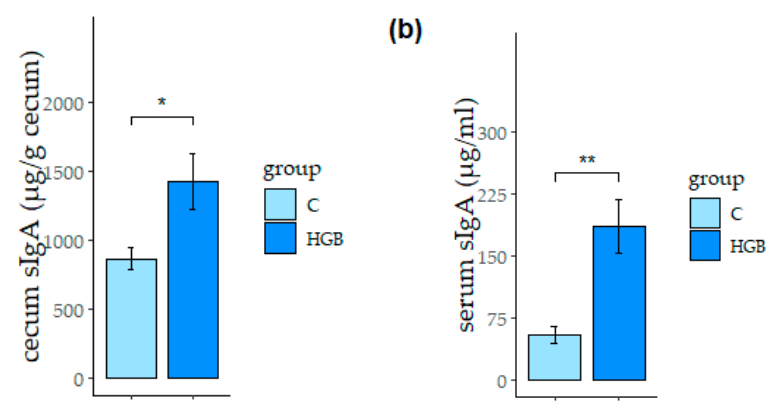
Figure 1. The concentration of sIgA in the cecum ( a ) and serum ( b ). Values are means ± SE, n = 8. * p < 0.05, ** p < 0.01 indicates a significant difference between each group, C: control group, HGB: high β -glucan barley group. sIgA, secretory immunoglobulin A.